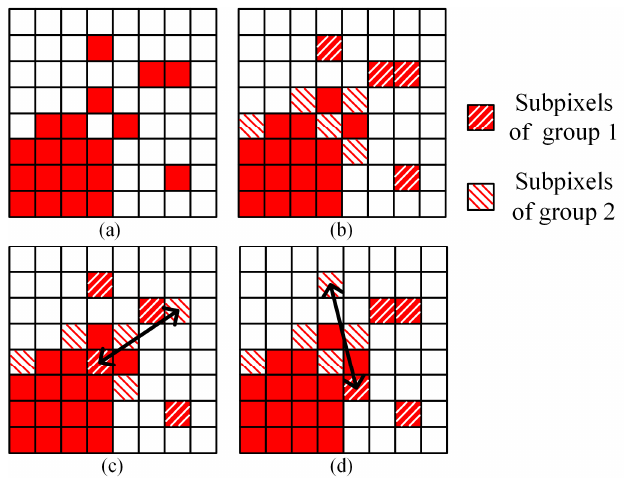
Figure 2. Interpretation of the PSA_MSA algorithm. ( a ) Original image, ( b ) randomly selected subpixels for swapping, ( c ) Swapping result 1, ( d ) Swapping result 2.